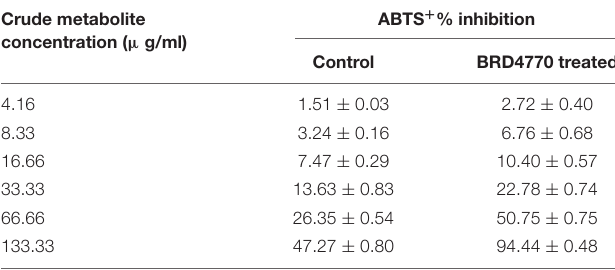
TABLE 2 | ABTS + % inhibition of 100 nM BRD4770-treated and non-treated (control) crude metabolite.